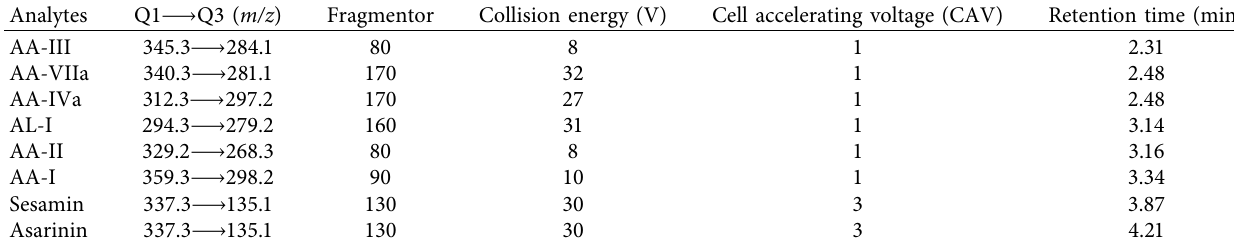
Table 2: The MS detection parameters of